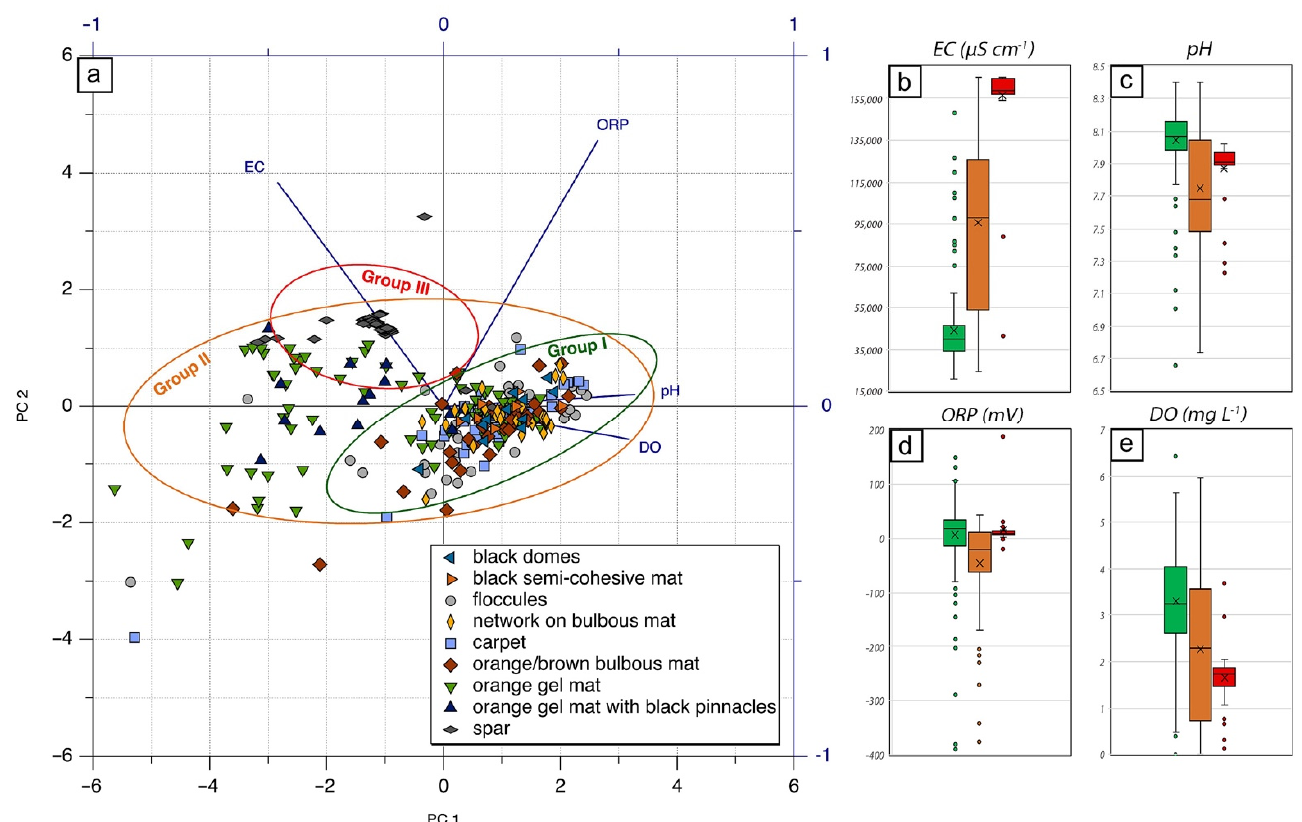
Figure 9. Principal component analysis (PCA) of bottom types using EC, pH, ORP, and DO as vari- ables ( a ). Homogenous subsets of bottom types separated by EC (Table 1) are circled with 95% con- centration ellipses for Group I (carpet, black domes, black semi-cohesive mat, floccules, network, and orange–brown bulbous mat), Group II (orange gel mat and orange gel mat with black pinnacles) and Group III (spar). Box and whisker plots showing ( b ) electrical conductivity (EC, µS cm − 1 ), ( c ) pH, ( d ) oxidation reduction potential (ORP, mV), and ( e ) dissolved oxygen (DO, mg L − 1 ), for bottom type groupings, as recorded in March 2019.